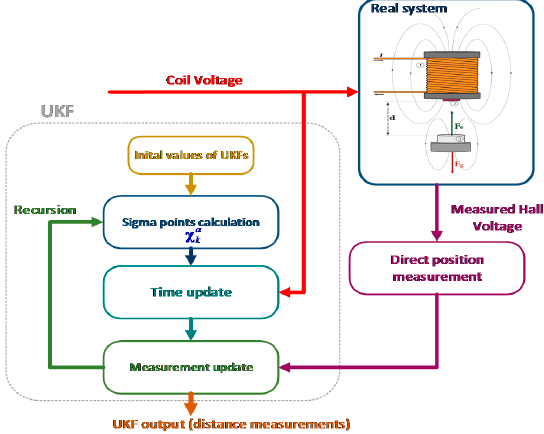
Figure 12 represents deploying UKF as a sensor fusion algorithm for accurate proximity measurement from a Hall sensor.